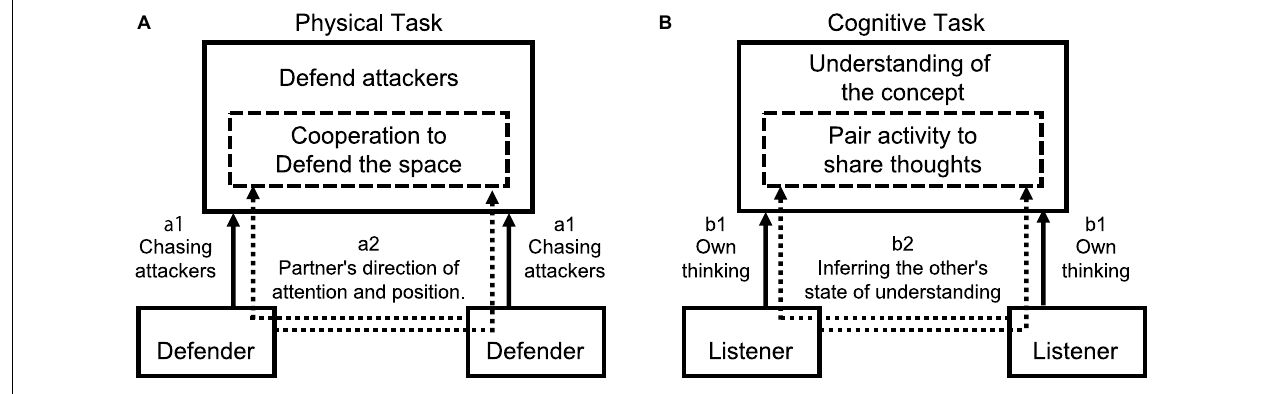
FIGURE 1 | Task structure of physical task (A) and cognitive task (B) . Panel (A) illustrates the task structure of a 3-on-2 tag game. The defender is required to defend the space in a coordinated way by chasing the attacker (a1) and inferring and sharing the partner’s attention to the attackers’ movement (a2). Panel (B) illustrates the task structure of the pair activity in the math class. Given that the pair activity task is to share each other’s thoughts, the children need to express their thoughts (b1) and infer the other’s state of understanding (b2). Solid lines denote individual behaviors and dotted lines denote pair behaviors.